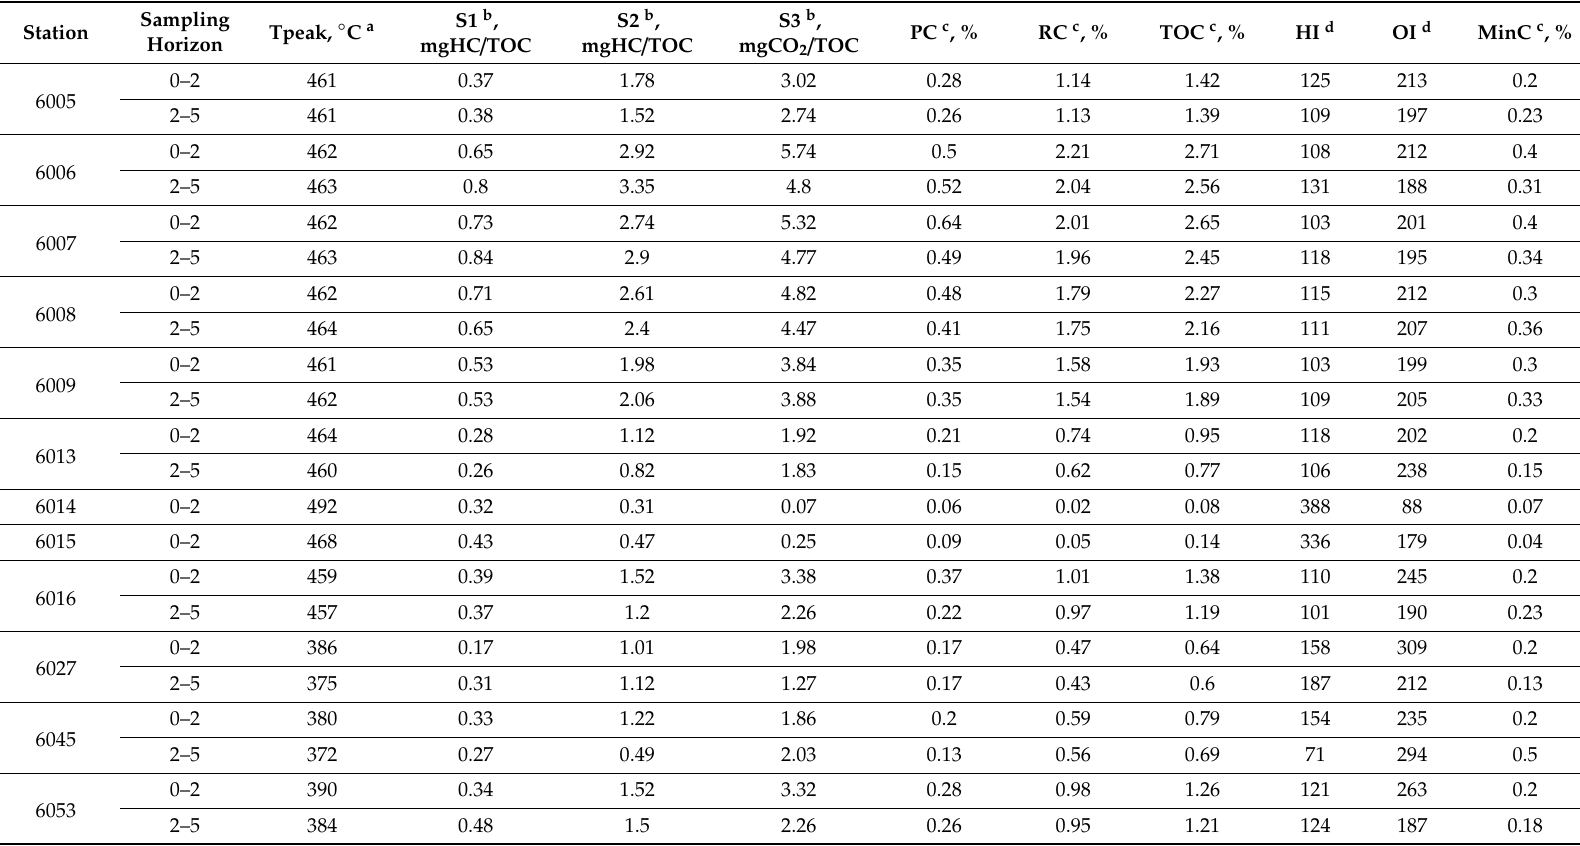
Table 2. Rock-Eval parameters of the Laptev Sea (LS) surface